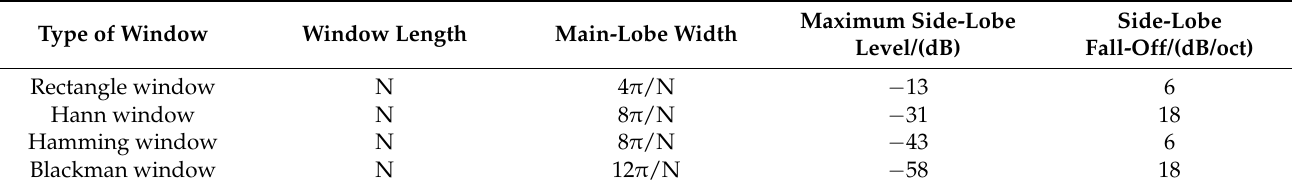
Table 1. Comparison of spectral characteristics of different cosine windows. Maximum Side-Lobe Side-Lobe Type of Window Window Length Main-Lobe Width Level/(dB) Fall-Off/(dB/oct) Rectangle window N 4 π /N − 13 6 Hann window N 8 π /N − 31 18 Hamming window N 8 π /N Blackman window